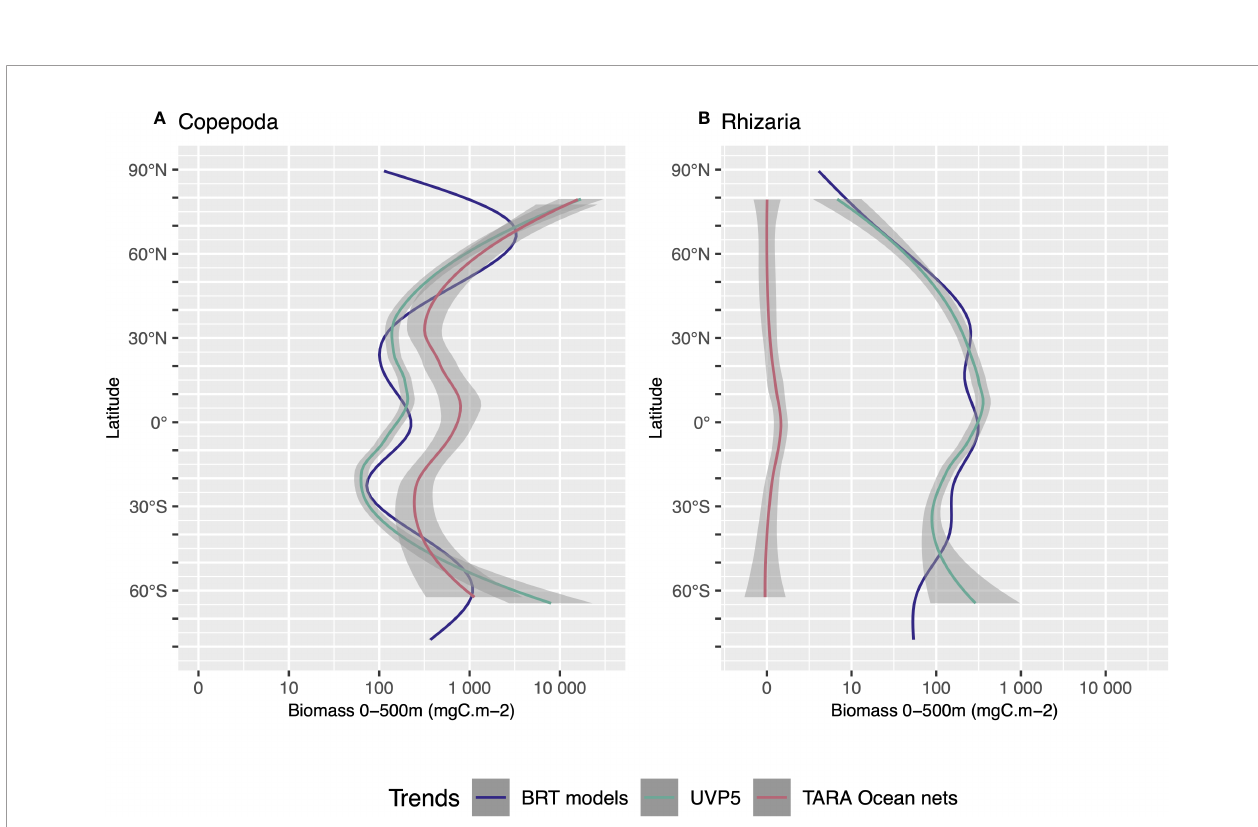
FIGURE 10 | Comparison of the latitudinal distribution of biomass mgC m -2 ) integrated over 0-500m depth between our models ’ estimation and the results from the Tara Ocean multinet (300 mm mesh size), for Copepoda (A) and Rhizaria (B) . Trends were obtained by using Loess regression on: BRT models (blue line) using the global model outputs for Copepoda or Rhizaria (summed across 0-200 m and 200-500 m depth); UVP5 data (green line) using the biomass as seen by the UVP5 between 0-500m; TARA Ocean net data (red line) using the sampling points between 0-500m. The Shaded areas represent the 95% con fi dence interval of the Loess fi t.